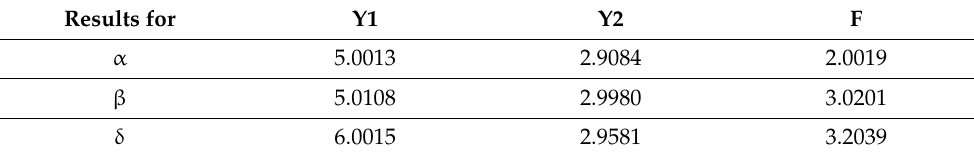
Table 4. Best Solutions.